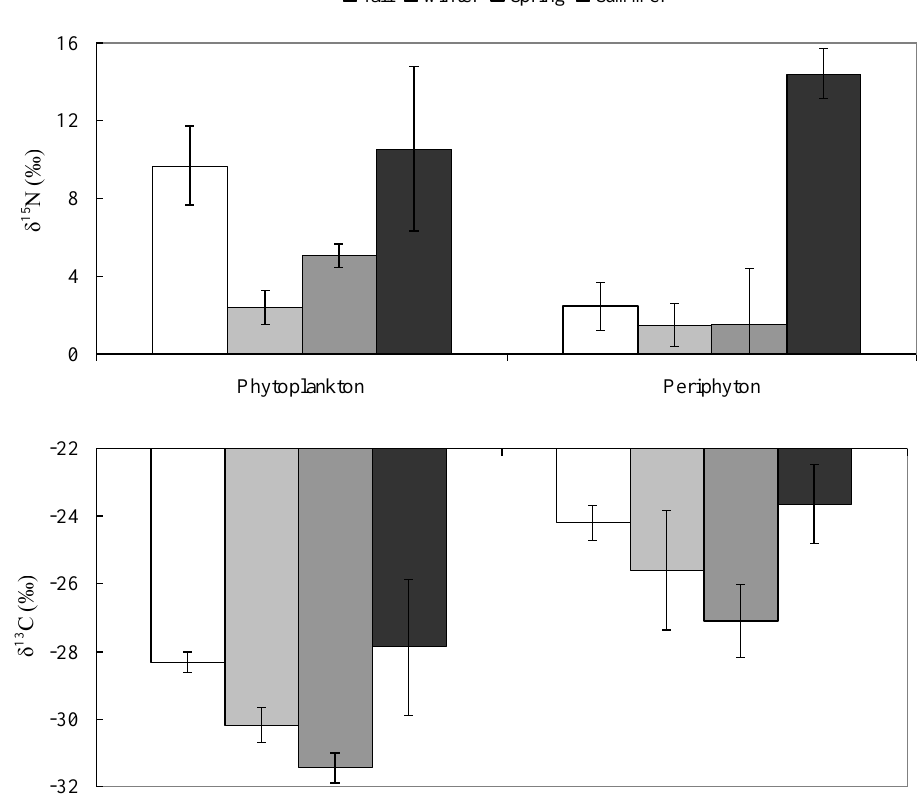
FIGURE 4 . Stable isotope signatures (mean ± 1SD) of phytoplankton and periphyton in the littoral zones of Meiliang Bay (Lake Taihu) during different seasons. Data concerning phytoplankton were cited from Zhou et